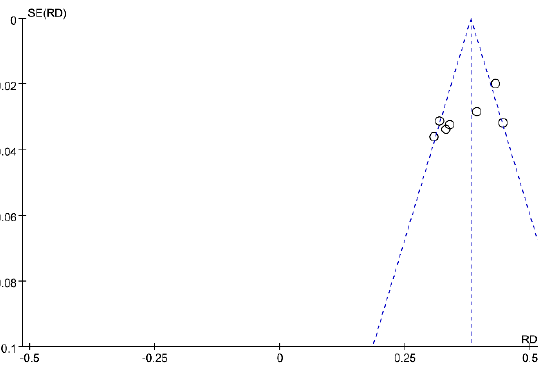
Figure 5. Funnel plot of seven studies of postpartum depressive symptoms.